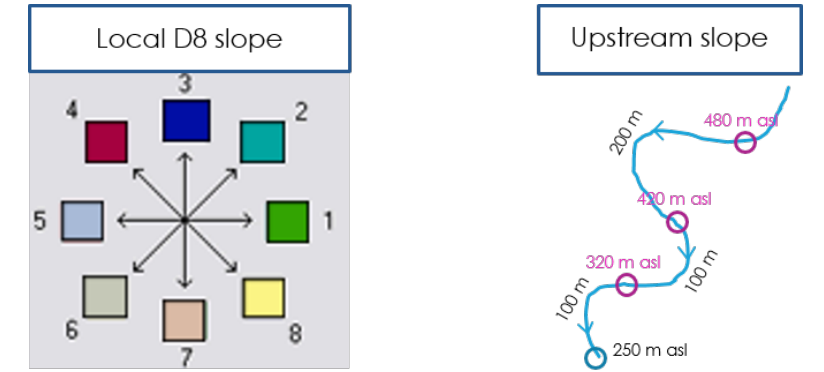
Figure 4. On the left: D8 drainage map definition. Each cell has a value between one and eight in order to identify the water-contributing cell. On the right: reach identification for several stream distances from the outlet point. The algorithm identifies three points (purple circles) along the stream channel: 100, 200, and 400 m upstream from the outlet (blue circle). For each point, the elevation is determined, and then, the elevation drop relative to the outlet point is